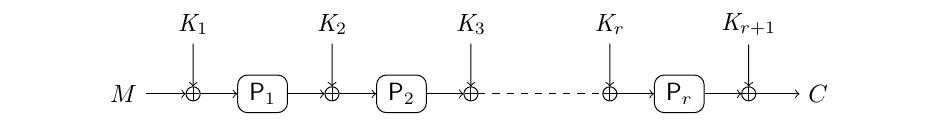
Figure 3: The r -round iterated Even–Mansour